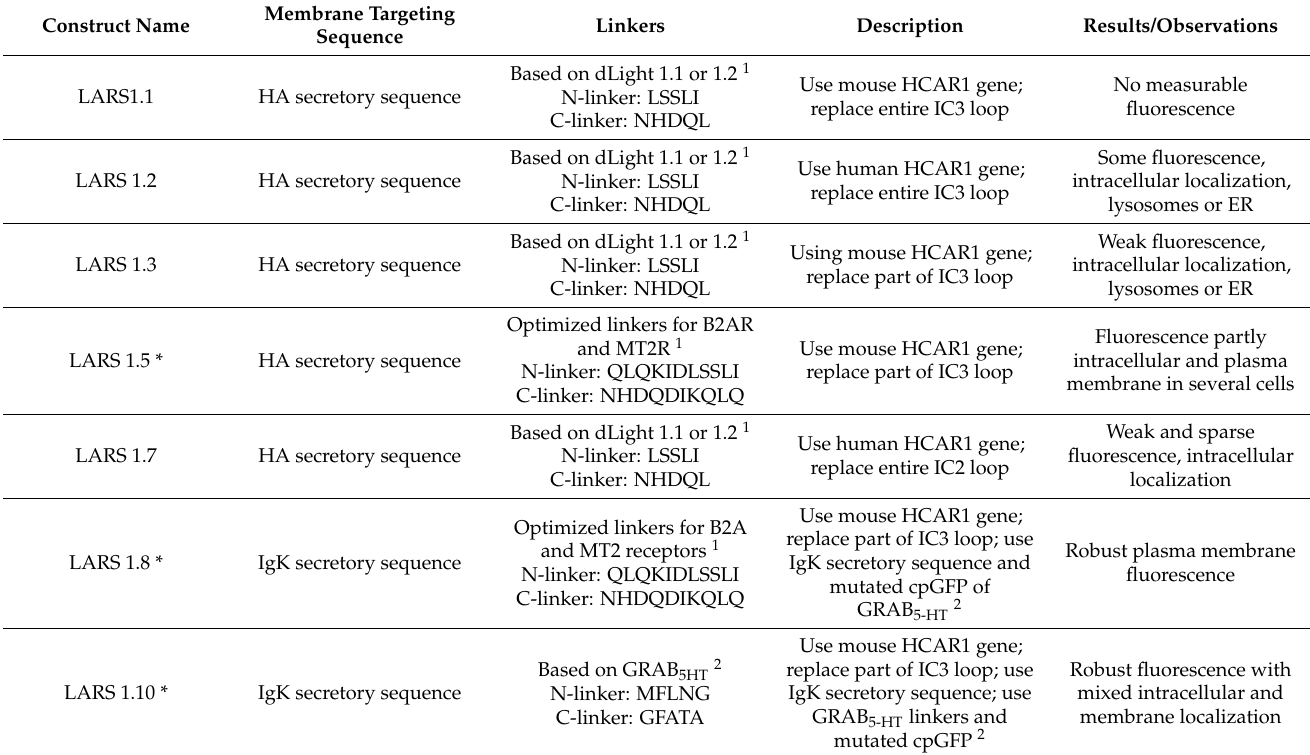
Table 1. Summary of main construct design